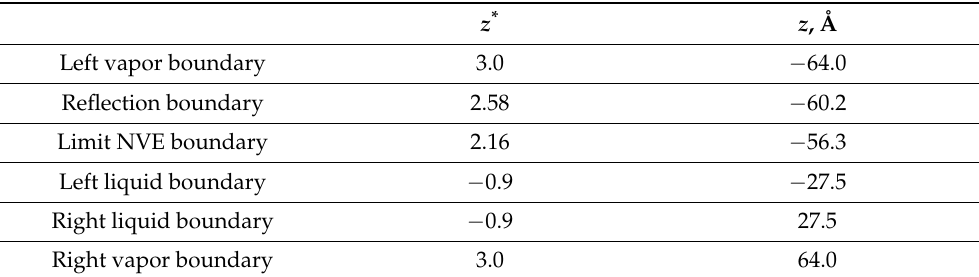
Figure 4. Steady-state vacuum simulation scheme with denoted interface region boundary positions and mass fluxes through the interfaces. The density profile for the scheme was obtained from the production run of the liquid-vapor phase equilibria simulation. Table 3. The normalized and absolute simulation boundary positions listed in Figure 4.